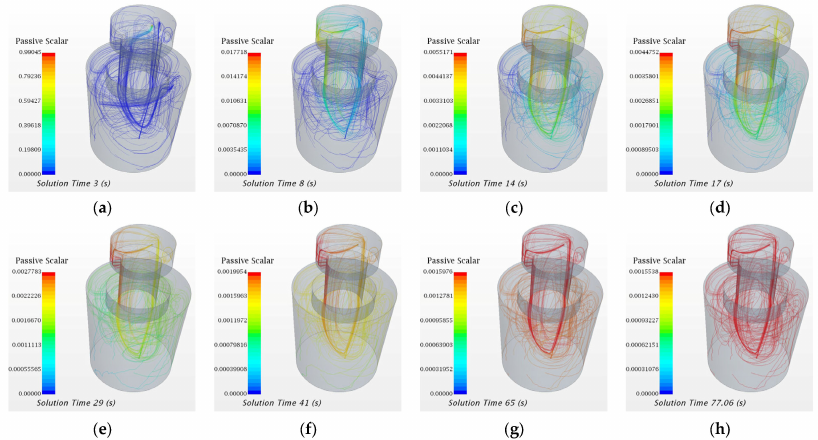
Figure 7. Evolution of streamlines of the passive scalar tracer in the water model of SSRF. ( a ) 3 s, ( b ) 8 s, ( c ) 14 s, ( d ) 17 s, ( e ) 29 s, ( f ) 41 s, ( g ) 65 s, and ( h ) 77.06